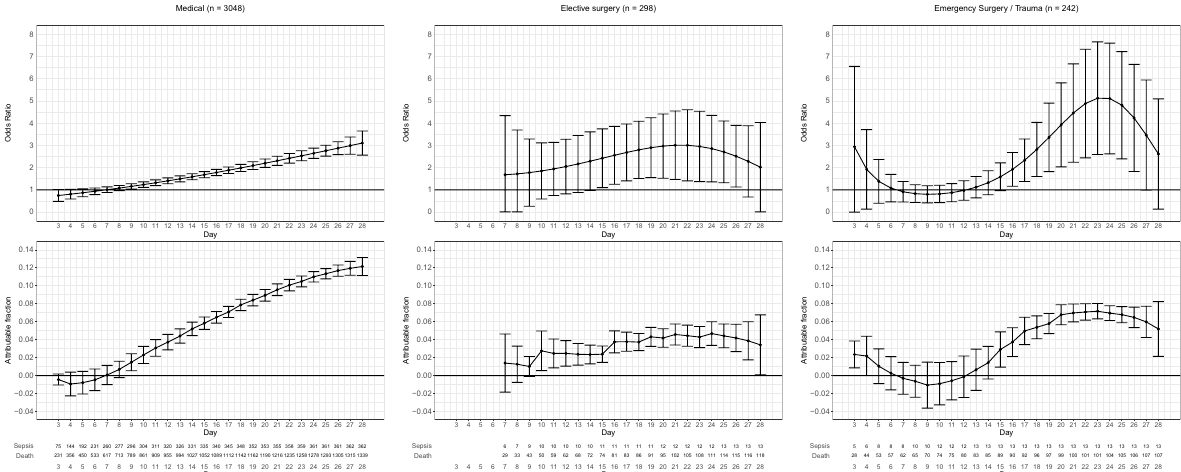
Fig. 2 Distribution of odds ratio (upper row) and AF (lower row) according to admission type (columns). The odds ratio should be interpreted as the odds ratio of dying up to a specific day ( x ‑axis) given that the patient has acquired